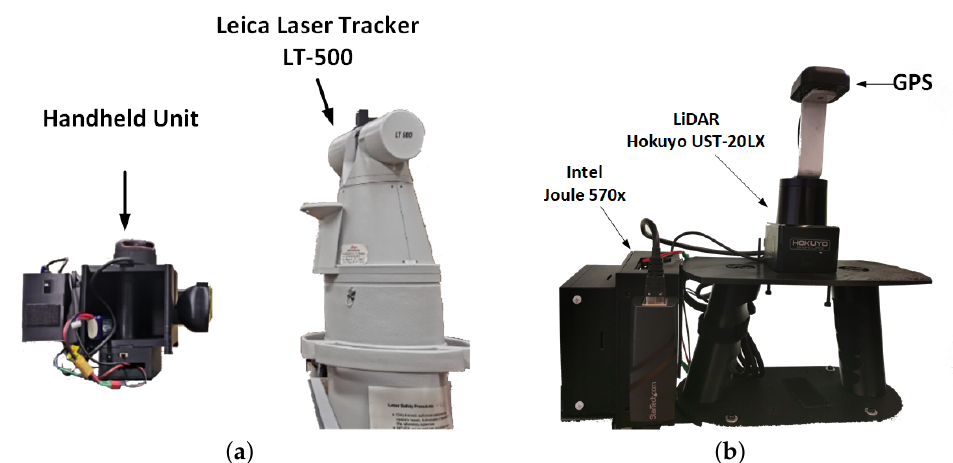
Figure 5. Two different setups used in the experiments. ( a ) The handheld device with Laser Tracker. ( b ) The handheld unit with